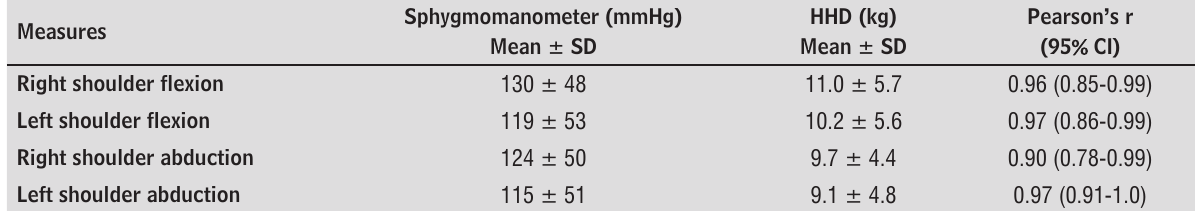
Table 2 - Validity results Measures